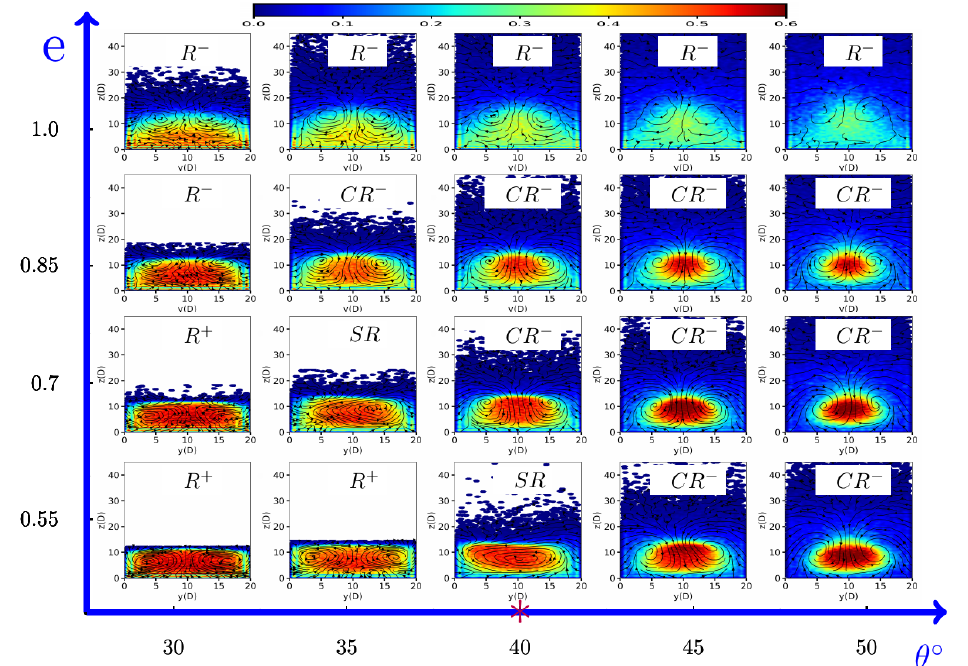
Figure 2: Cross-section of the flow showing the particle volume fraction together with the streamlines for various values of inclination angles and restitution coe  cients e . A variety of di ↵ erent flow regimes are observed:(i) Dilute flow regime with a pair of longitudinal rolls R  leading to a downward motion in the dense part of the flow (i.e., in the center of the cell); (ii) Dense flow regime with a pair of longitudinal vortices R + leading to an upward motion in the denser part of the flow; (iii) Supported flow regime CR  characterized by a dense core C and a pair of longitudinal rolls R  ; (iv) flow regime S R with a single longitudinal